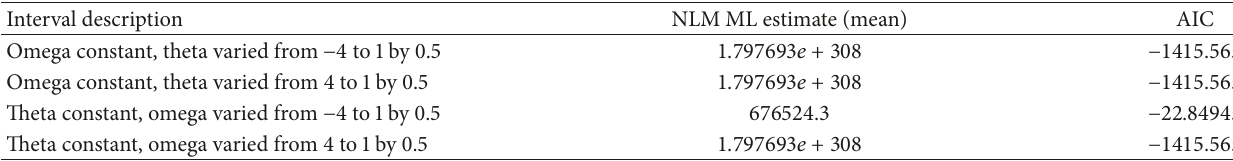
Table 13: Summary of results for lambda = 0.1, 𝑛 = 10 𝑖 , 𝑖 = 6 .